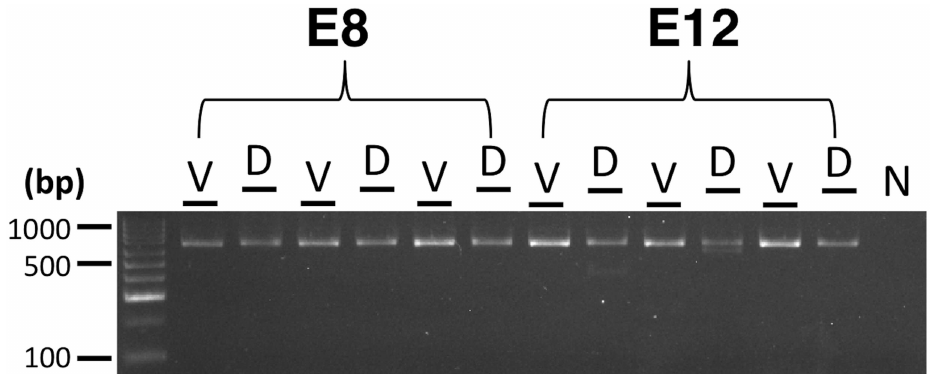
Fig 3. RT-PCR of the previously undocumented ASIP alternatively spliced transcript containing novel exon 7 in Japanese quail in three replicates per developmental stage. The expectedampliconlengthis 738 base pairs (Table A in S1 File). The developmental stage is abovethe gel lanes as well as body surface: V = Ventral, D = Dorsal. N =